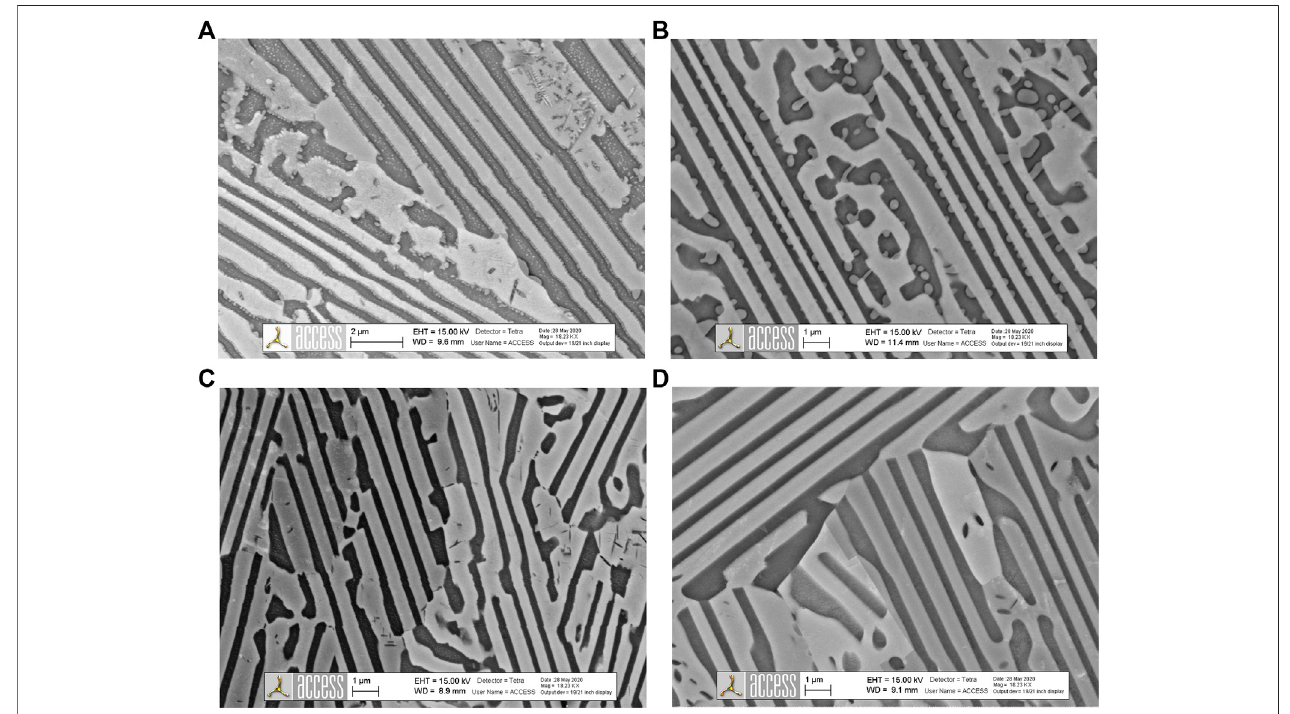
FIGURE 5 | Scanning Electron Microscopy micrographs of samples of the Ni 44 Fe 20 Cr 20 Al 16 alloy after treatment at 750 ° C (A) and after 950 ° C (B) , the